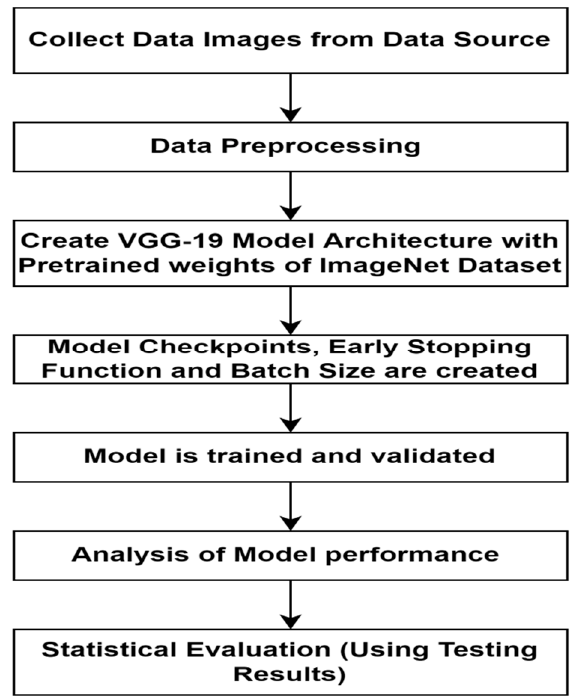
Figure 6. Algorithms steps for model training and evaluation.